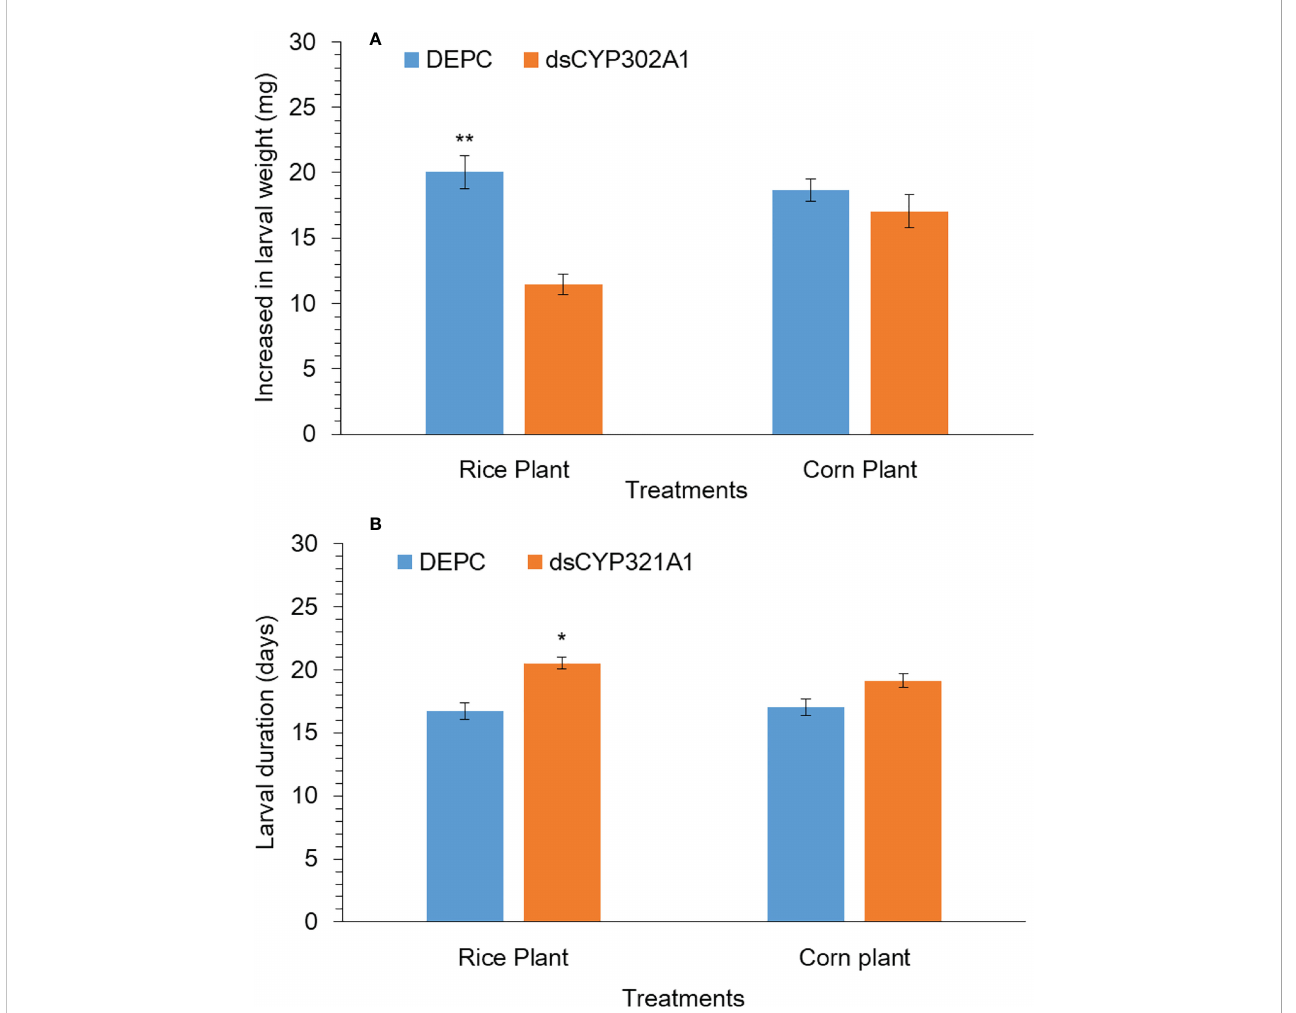
FIGURE 7 Larval weight (A) and larval duration (B) of S. frugiperda larvae after treated with diet containing dsCYP302A1and DEPC-treated water followed by feeding on rice and host plants. Data shown are mean ± SE. Treatments were compared using Student ’ s t test. * and ** represent P < 0.05 and P < 0.01,